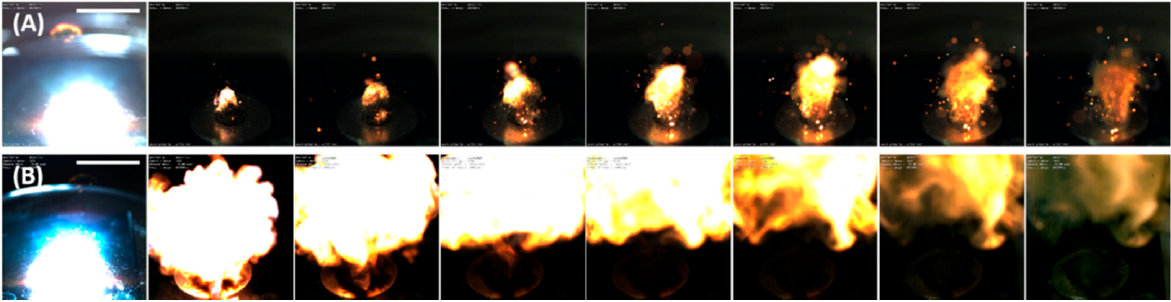
Figure 2. Sequences of combustion images of the ( A ) Al/In 2 O 3 _µm (time interval between images of 10 ms) and ( B ) Al/In 2 O 3 _nm energetic formulations, respectively with an interval of time between images of 10 ms and 1 ms, respectively. The white scale bar (on top on first images) represents 20 mm.